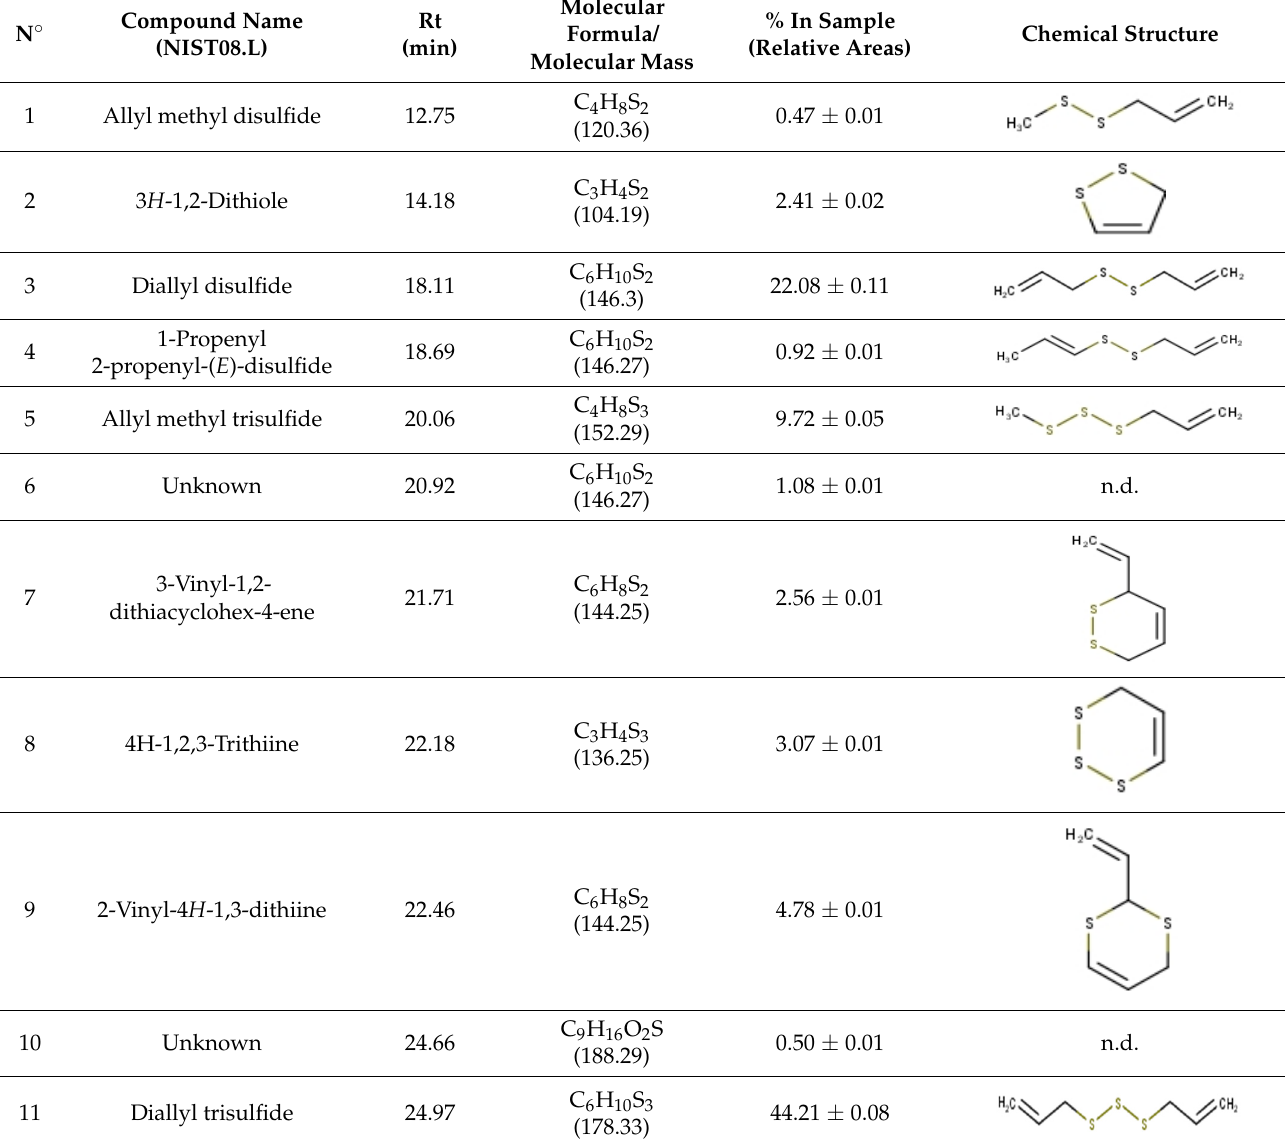
Table 1. Chemical composition of the volatile oil of A. sativum (garlic).